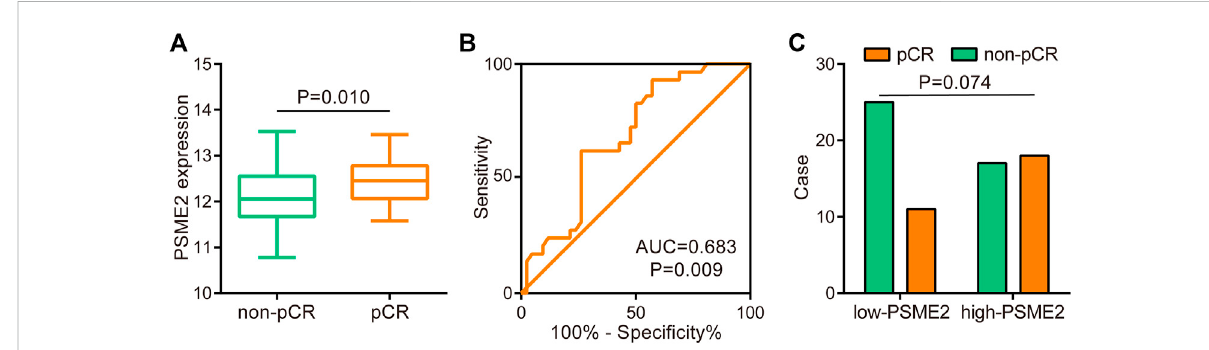
FIGURE 7 Predictive role of PSME2 in immunotherapy in the GSE173839 dataset (A) Expression level of PSME2 in BrCa with various immunotherapeutic responses (B) ROC analysis of predictive values of PSME2 in the BrCa immunotherapy cohort. Data of Figure 7 was obtained from the GSE173839 dataset (C) Immunotherapeutic response rates between low- and high- PSME2